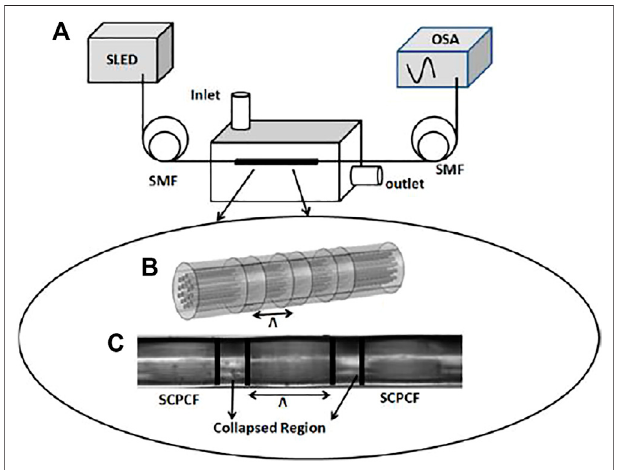
FIGURE 1 | (A) Schematic of the proposed experimental setup. (B,C) Schematic of the SCPCF with collapsed region and the microscopic image of the collapsed region, respectively.